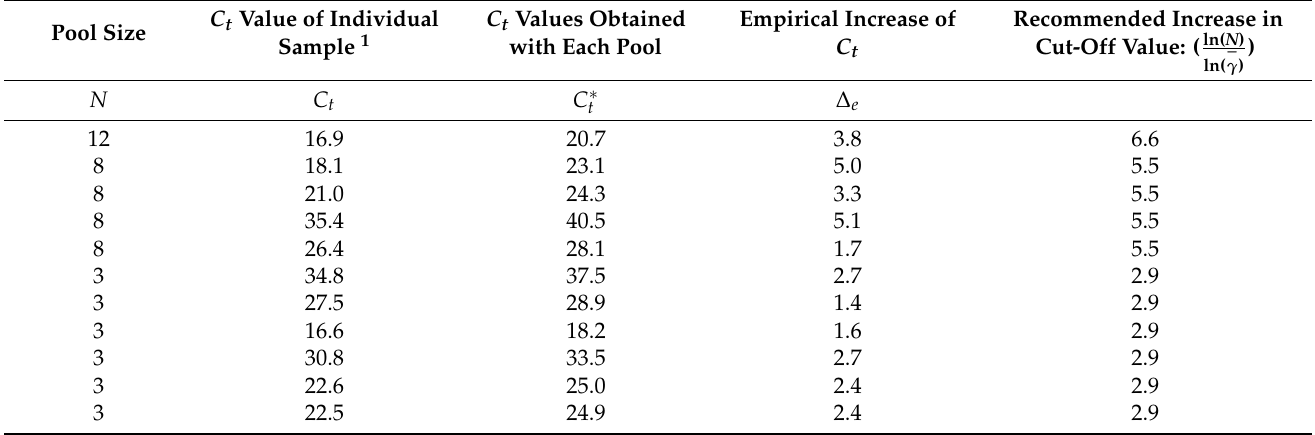
Table 1. C t values in pools with a single positive sample and recommended increase in cut-off